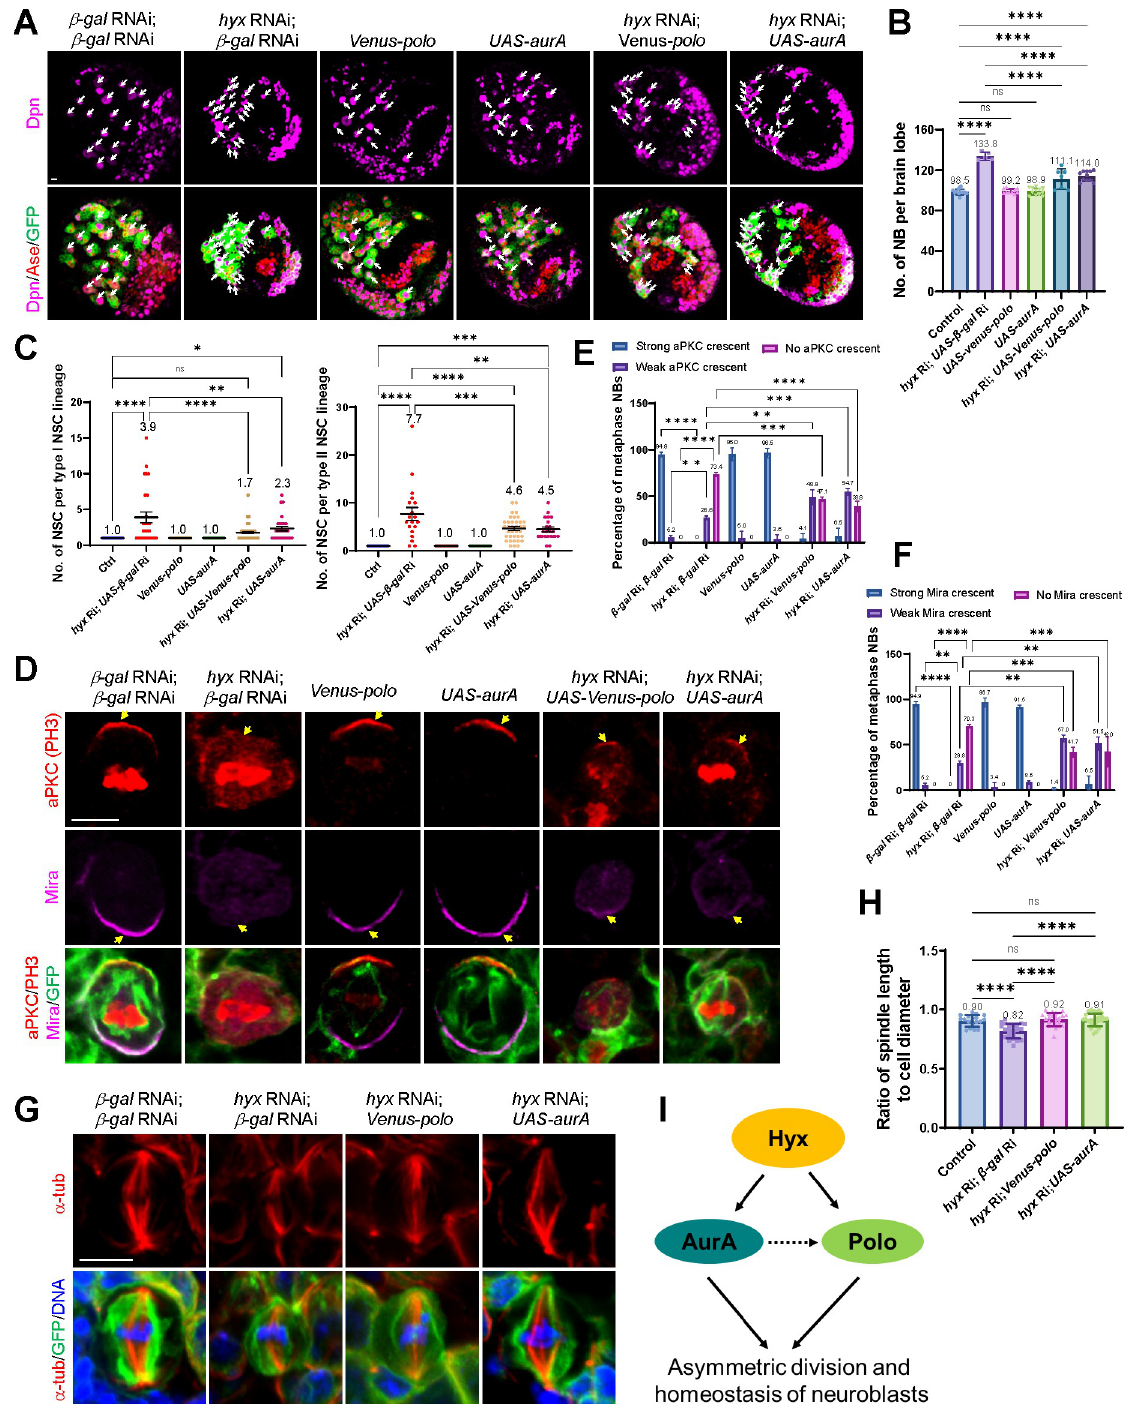
Fig 7. Polo and AurA are 2 key downstream targets of Hyx and functional for preventing hyx -depletion mediated NSC overproliferation. ( A ) Third instar larval brains from control (UAS- β -Gal RNAi; UAS- β -Gal RNAi), hyx knockdown with UAS control ( hyx RNAi; UAS- β -Gal RNAi), hyx knockdown with polo expression ( hyx RNAi; UAS-venus-polo ) and hyx knockdown with aurA expression ( hyx RNAi; UAS-aurA ) were labelled with Dpn, Ase, and GFP. RNAi was driven by insc -Gal4. ( B ) Average NSC number per brain lobe (with SD) for genotypes in A. Control: 98.5 ± 2.4 NSC, n = 11 BL; hyx RNAi; UAS- β -Gal RNAi: 133.8 ± 4.01 NSC, n = 5 BL; venus-polo : 99.2 ± 2.4, n = 10 BL; UAS-aurA : 98.9 ± 3.6, n = 12 BL; hyx RNAi; UAS-venus-polo : 11.1 ± 10.1, n = 7 BL; hyx RNAi; UAS-aurA : 114.0 ± 5.1 NSC, n = 11 BL. ( C ) Average NSC number per lineage (with SEM) for genotypes in A. Type I: Control, 1.0 ± 0 NSC, n = 20 NSC lineage;